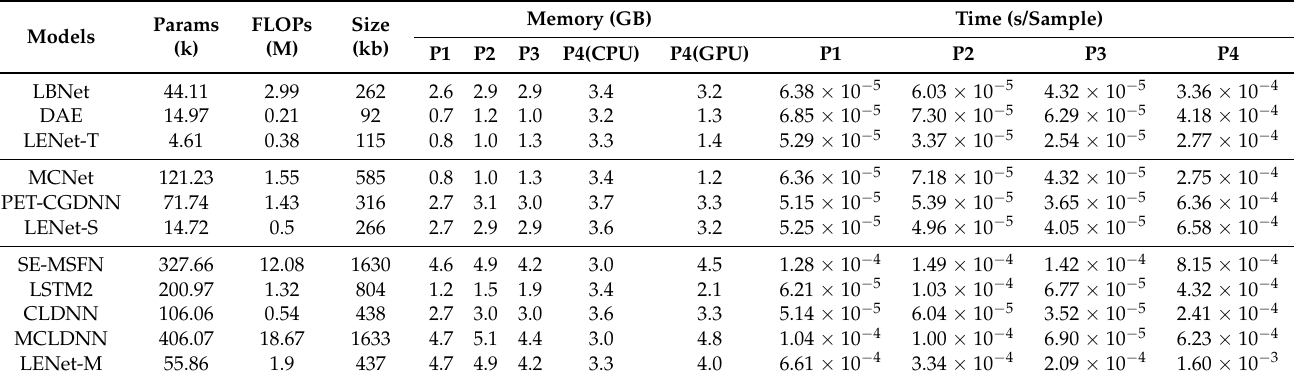
Table 9. Complexity of different models on the 2016A dataset. Params is trainable parameters of the model. Size is the amount of storage space consumed by the model’s weight file. Memory indicates the memory usage of a single GPU graphics card on a P2 platform. The batch size is 128. The inference time is the average time spent per sample for a batch size of 128 using all 40,000 test